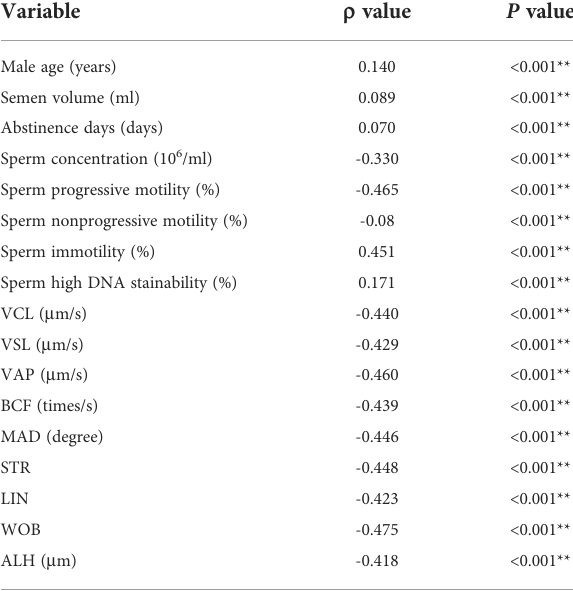
TABLE 1 Correlation between sperm DFI and semen conventional parameters.